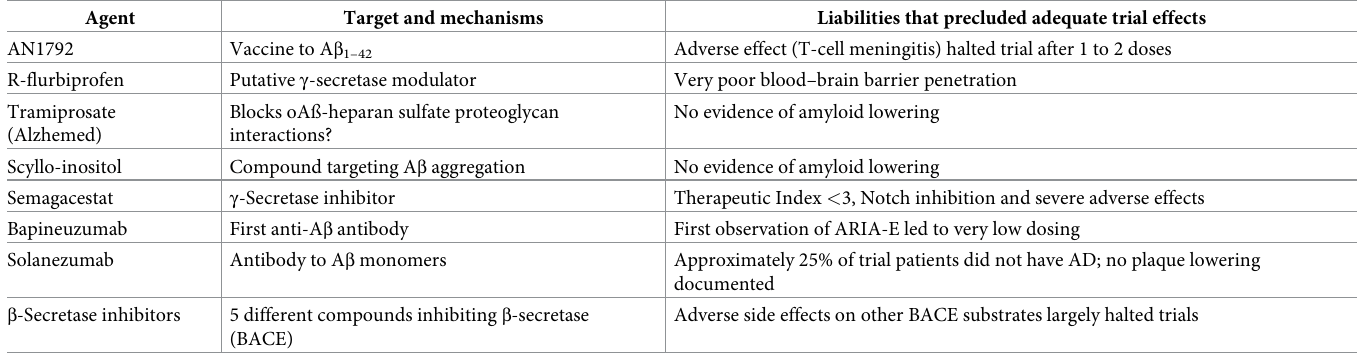
Table 1. Apparent reasons for “failure” in some previous anti-amyloid clinical